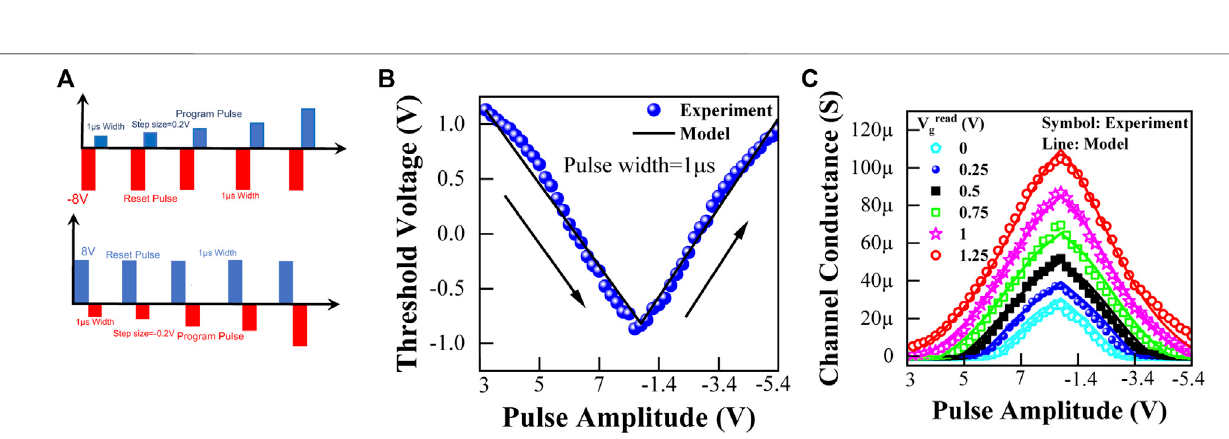
FIGURE4|(A) LTP – LTDpulsescheme.Duringthepotentiation,theamplitudeofthepulseisincreasedby0.2 Vineachstep,andduringdepressiontheamplitude is reduced by − 0.2 V. A full ( ± 8 V) RESET pulse precedes each potentiation or depression pulse to ensure stable WRITE operation. (B) Threshold voltage modulation curveshowstheevolutionofthresholdvoltageaftereachpulseduringgradualpotentiationanddepressionoperation. (C) Asthethresholdvoltagechangeswithprogram and erase operation, the channel conductance at a fi xed gate voltage also varies. Variation of channel conductance is shown here. The number of conductance state depends on the WRITE pulse numbers as well as choice of V gread